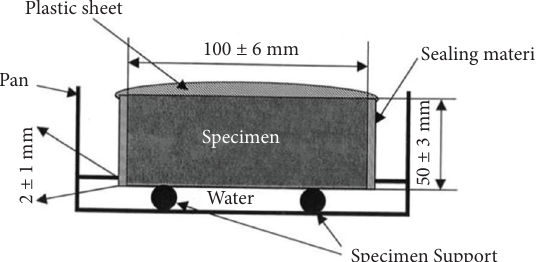
Figure 5: Schematic of the water sorptivity measurement.